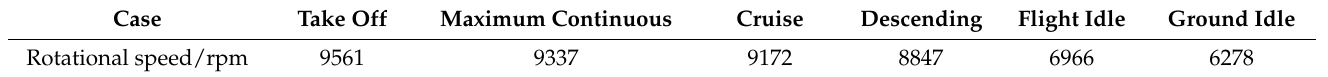
Table 2. Typical operational conditions